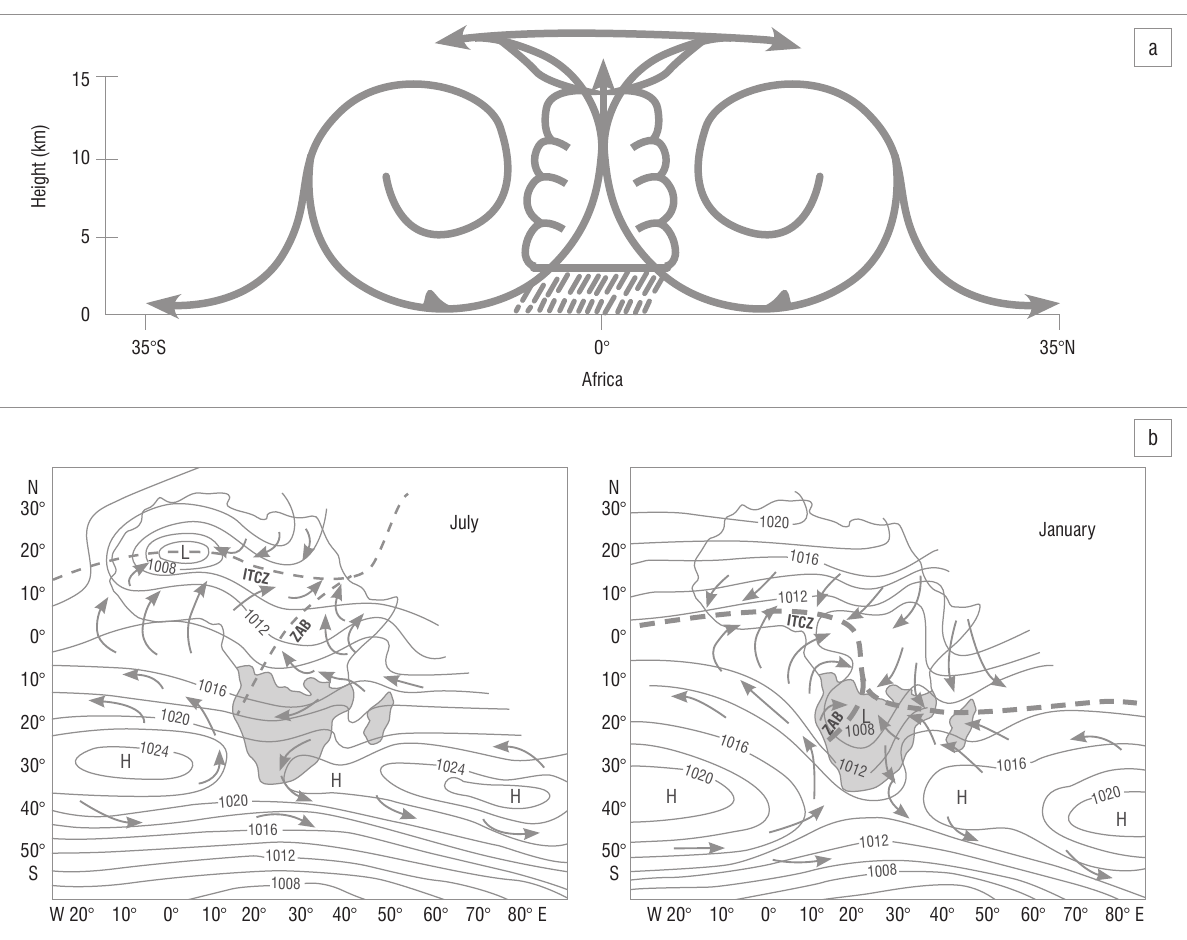
(a) Schematic of the Hadley circulation over Africa in the form of a vertical cross-section from the surface to 15 km extending along the north/south length of Africa. Ascending air, cloud and rain dominate the equatorial region; descending air, drying and warming dominate the greater part of the continent. (b) The mean surface pressure (mb) and wind (heavy arrows) fields for each season: July, northern hemisphere summer/southern hemisphere winter, and January, northern hemisphere winter/southern hemisphere summer. The Intertropical Convergence Zone (ITCZ) and the Zaire Air Boundary (ZAB) are shown by heavy dashed